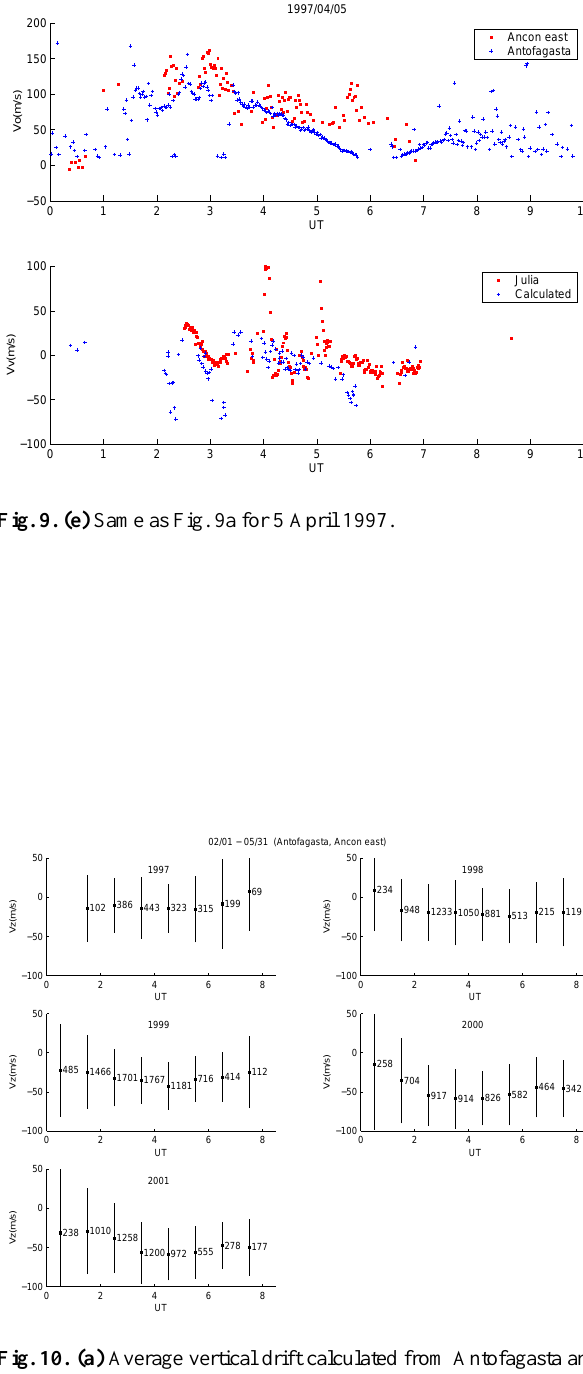
Fig. 9. (d) Same as Fig. 9a for 4 April 1997.